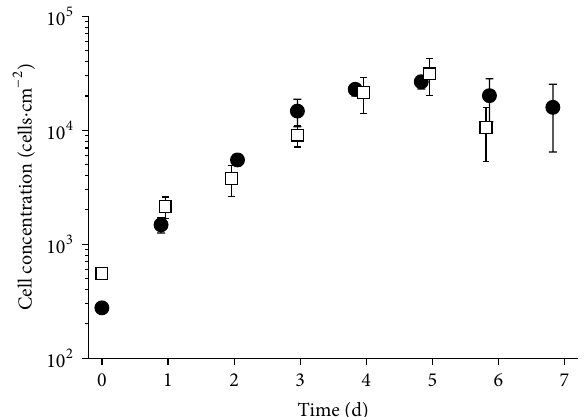
Figure 5: Growth kinetic of hUC MSCs on Plastic Plus microcar- riers in spinner flasks in 100 mL DMEM LG medium with seeding density of 8000 cells ⋅ cm −2 (HUC #255, female: white squares; HUC #256, male: black